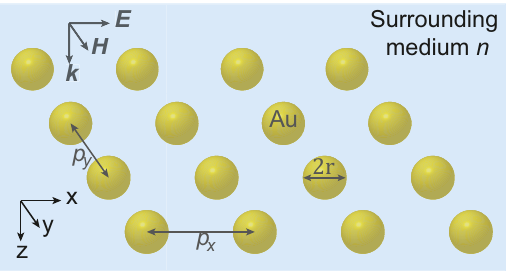
Figure1: (Coloronline)Schematicviewofthegoldnanospherearray in the surrounding medium with refractive index n